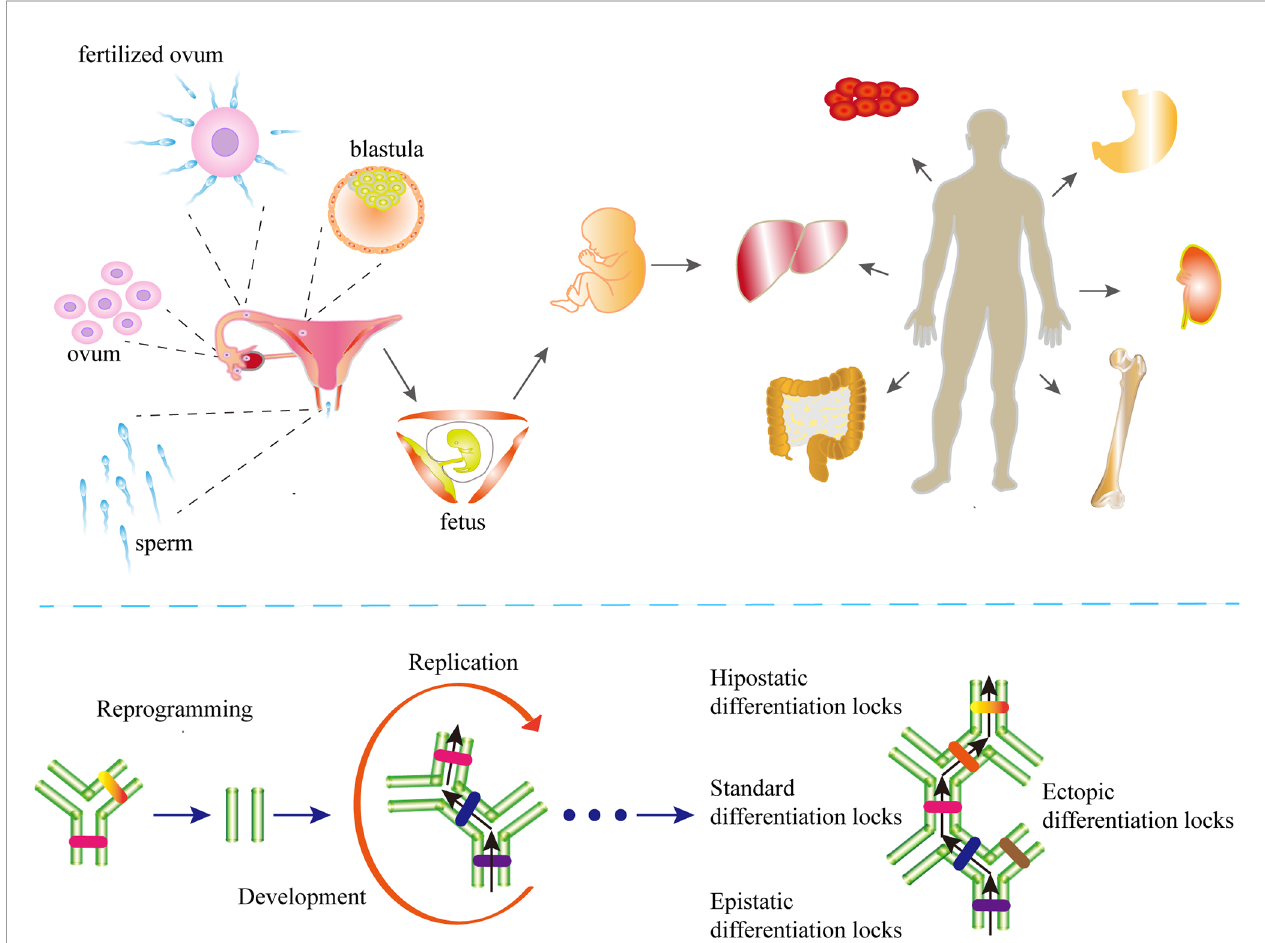
FIGURE 1 | The differentiation locks in cell differentiation. A coordinated gamete and embryo epigenetic reprogramming can eliminate the epigenetic markers carried by their parents, reverse and restore to the state of totipotency, which is the condition of post-fertilization differentiation. Differentiation lock is the composition of epigenetics in cell differentiation The existence of differentiation lock is crucial to maintain the irreversible state of differentiation. The formation of differentiation locks is dependent on intercellular signaling and cell-mesenchymal interactions. The differentiation locks that maintain the state-speci fi c modi fi cations of a cell are called the standard differentiation locks (SDLs), those that maintain the modi fi cations of the previous stage are called the epistatic differentiation locks (EDLs), and the differentiation locks that maintain the modi fi cations of the next stage are called the hypostatic differentiation locks (HDLs). The SDLs may contain parts or all of the EDL modi fi cations. Differentiation locks that do not exist in a cell ’ s own differentiation path are collectively called ectopic differentiation locks (EcDLs). Differentiation locks replicate, inherit, and develop during the differentiation and division of